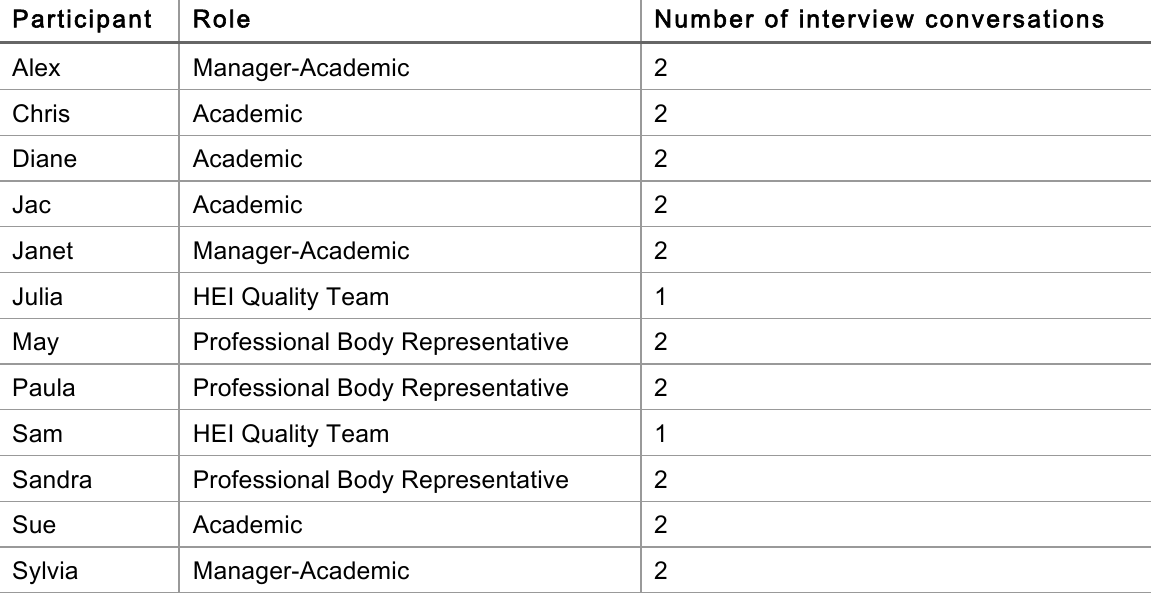
Table 2: Summary of participants and interview conversations